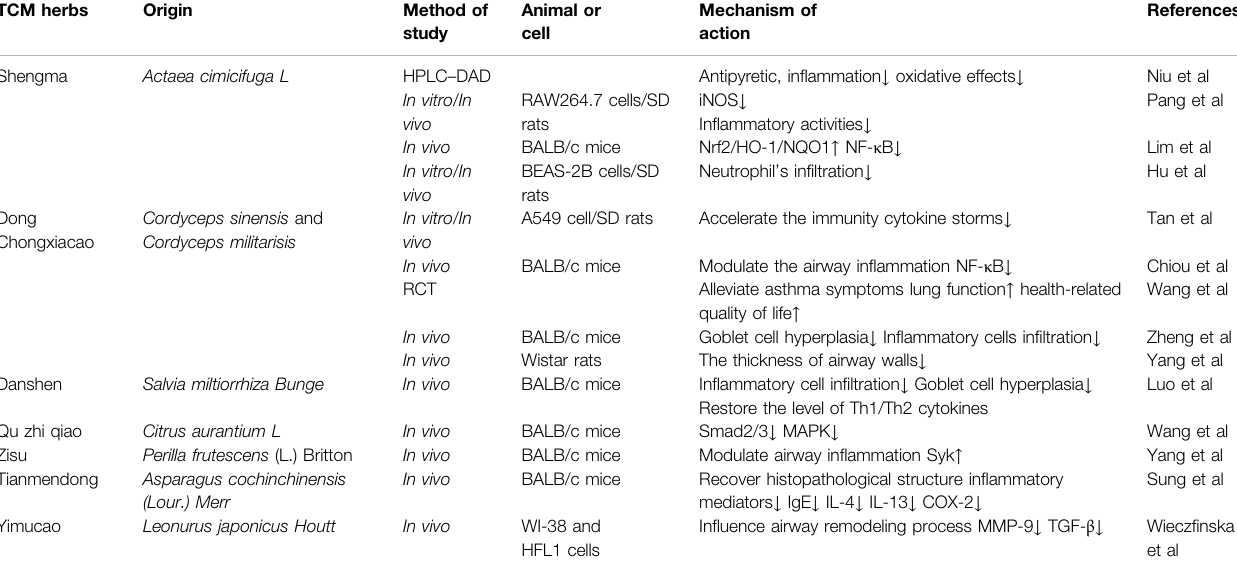
TABLE 2 | Major anti-airway in fl ammation and remodeling mechanisms of the traditional herbs. TCM